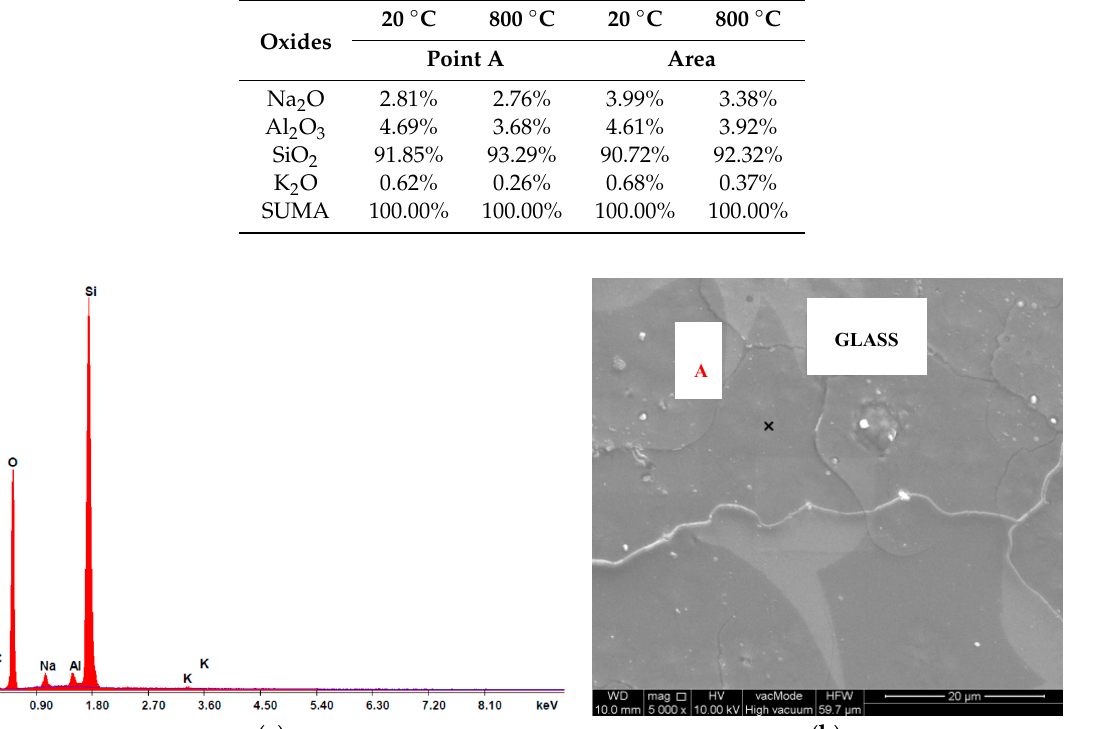
Table 13. Analysis of composition of glass cullet determined from point A and from the area—weight %. Figure 14. Analysis of glass cullet, 20 °C: ( a ) chemical composition spectrum of SEM-EDS, point A; ( b ) microstructure of glass, point A; ( c ) SEM-EDS chemical composition spectrum, area; ( d ) glass microstructure, area.